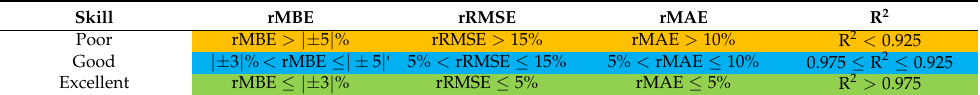
Table 2. The resulting ranges for each metric and class. Green represents excellent performance, blue represents good performance, and yellow represents poor